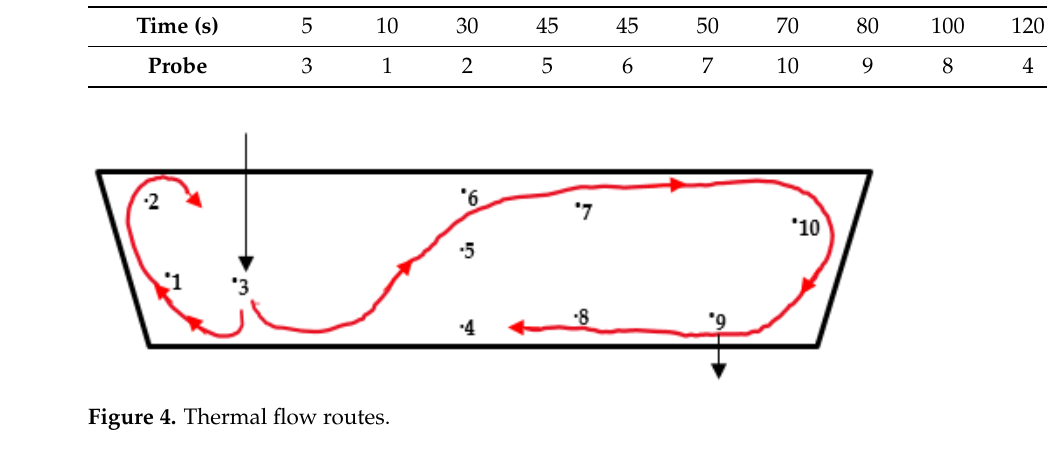
Figure 6. Comparison of temperature measurement at No.9 point in the non-isothermal water model (Q = 1500 L/h, H = 0.4 m, ΔT = 20 °C). 3.1.3. CFD Results of Hotter and Cooler Inflow (Bare Water Model) Figures 7 and 8 exhibit the temperature profiles and flow vectors at the symmetry plane after pouring hotter (ΔT = 20 °C) and cooler (ΔT = −20 °C) inflow in the water model at t = 20 s, 65 s and 100 s, respectively. In order to clearly visualize the flow pattern, the vector length was not varied with respect to magnitude since the bath velocity was very small compared to the inlet velocity. The incoming flow jet quickly hits the bottom and forms an intense mixing near the inlet region (Figure 7a and Figure 8a). Then, the hot incoming stream floats upwards to the surface while the cold flow extends, spreading along the bottom (Figure 7b and Figure 8b) because the cold fluid is denser and heavier than the hot fluid. A counter-clockwise circulation is formed near the outlet region with